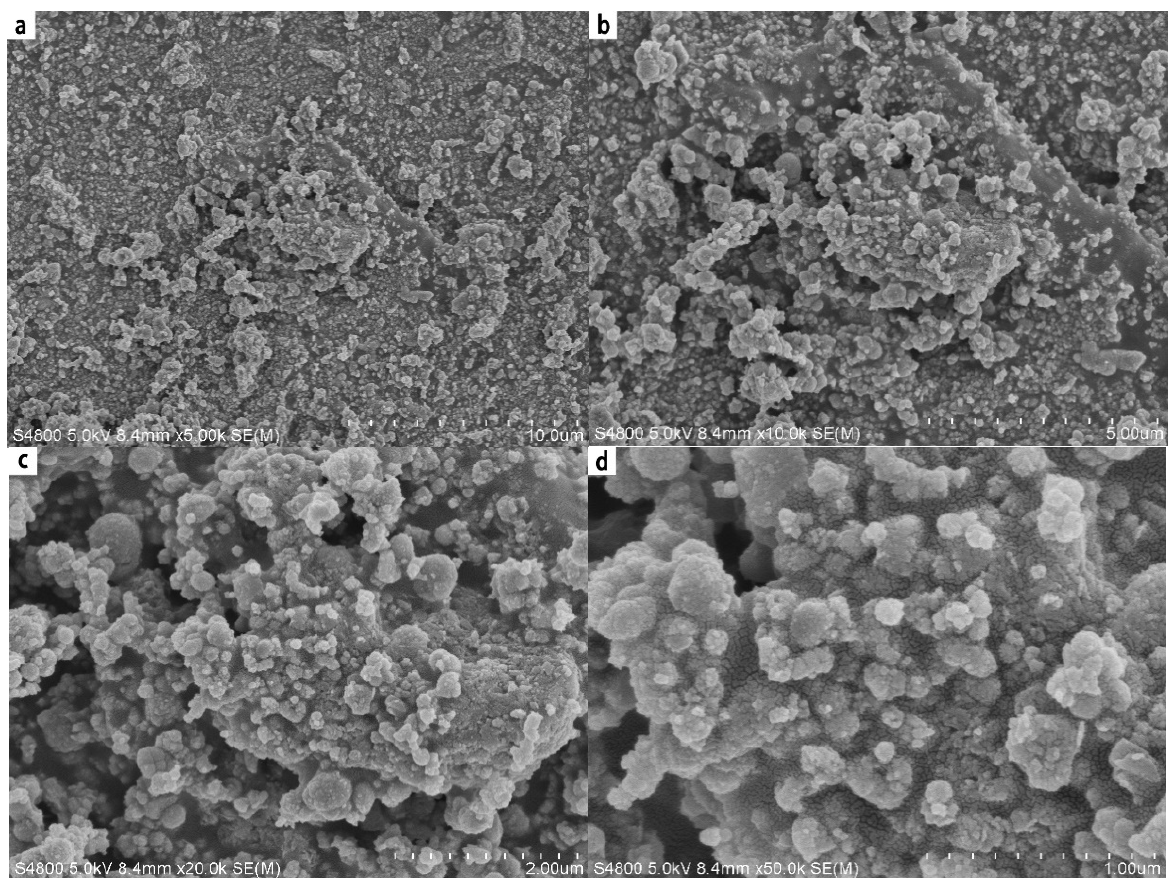
Figure 16. SEM of Co-nZVI/GAC after reaction.The sample is magnified 5000 times ( a ), The sample is magnified 10,000 times ( b ), The sample is magnified 20,000 times ( c ), The sample is magnified 50,000 times ( d ).